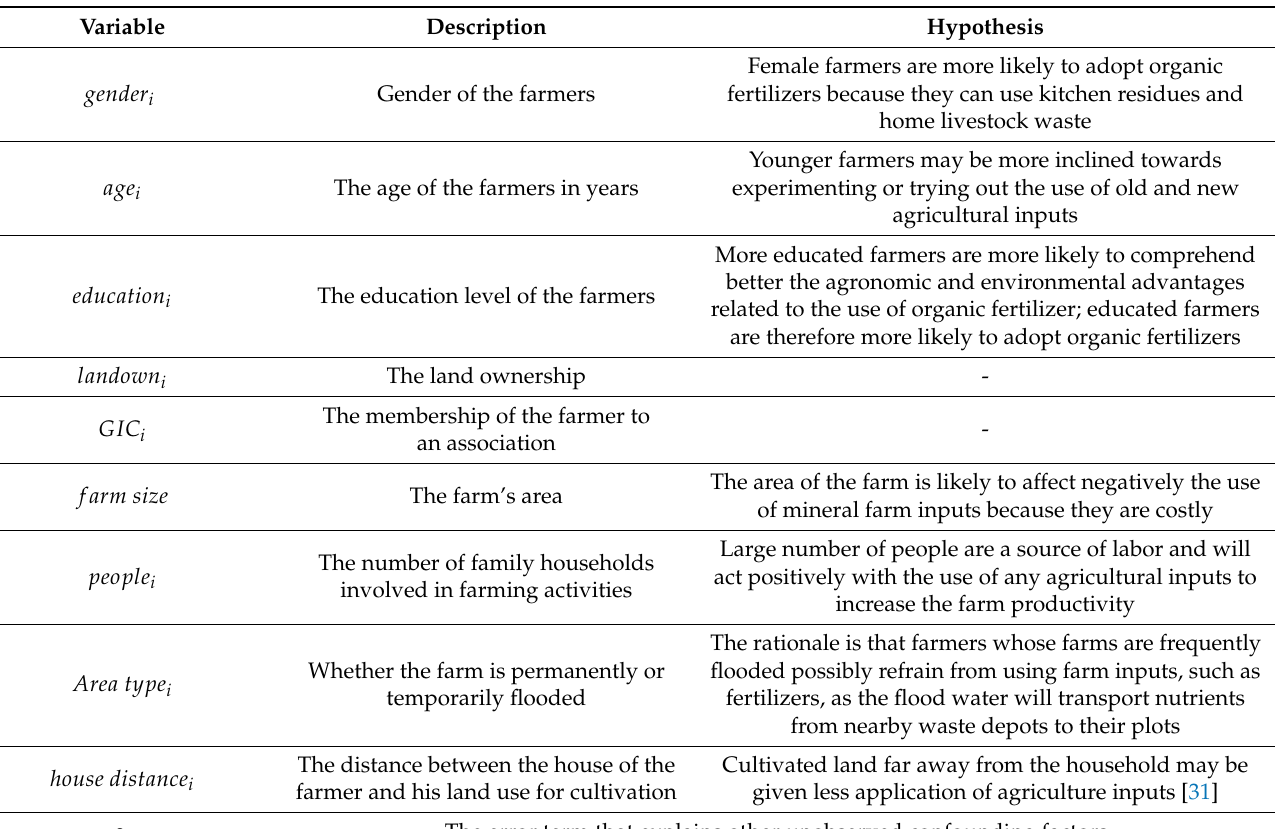
Table A2. Description of variables used in the first model.